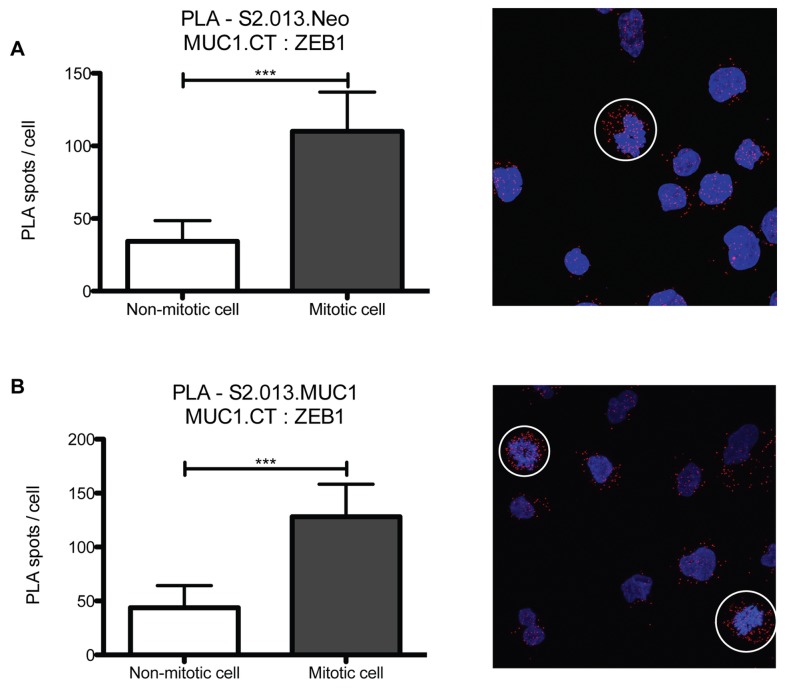
PLA analysis of MUC1.CT interaction with ZEB1 in mitotic cells.Proximity ligation assay of MUC1.CT with ZEB1 was analyzed in mitotic cells versus non-mitotic cells. A) PLA results from mitotic (circled) or non-mitotic cells in S2.013.Neo or S2.013.MUC1, B indicate a roughly 2-3-fold increase in MUC1.CT and ZEB1 interaction. In addition, this interaction occurs mainly in the cytoplasm, not in the nuclei. (*** p < 0.0005).